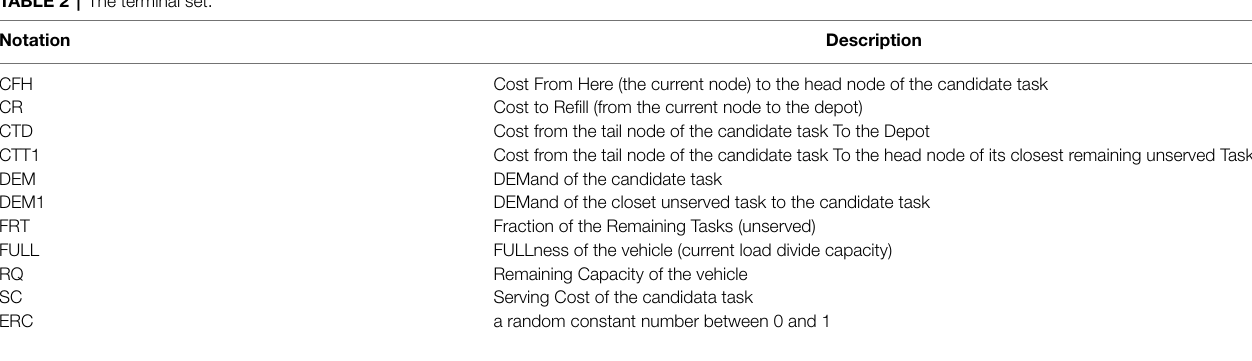
TABLE 2 | The terminal